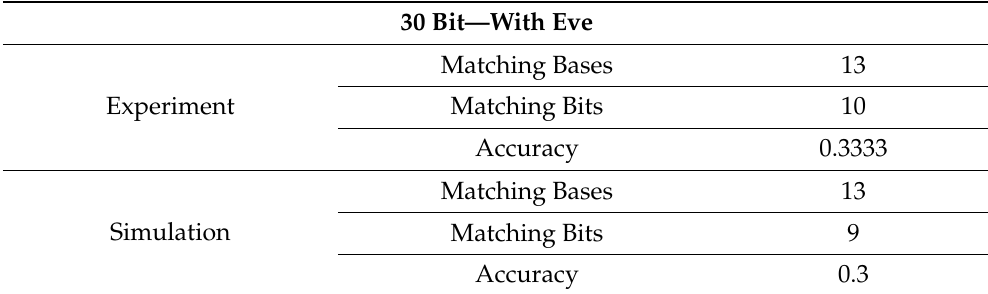
Table 7. A 30 bit accuracy for experiment and simulation—with